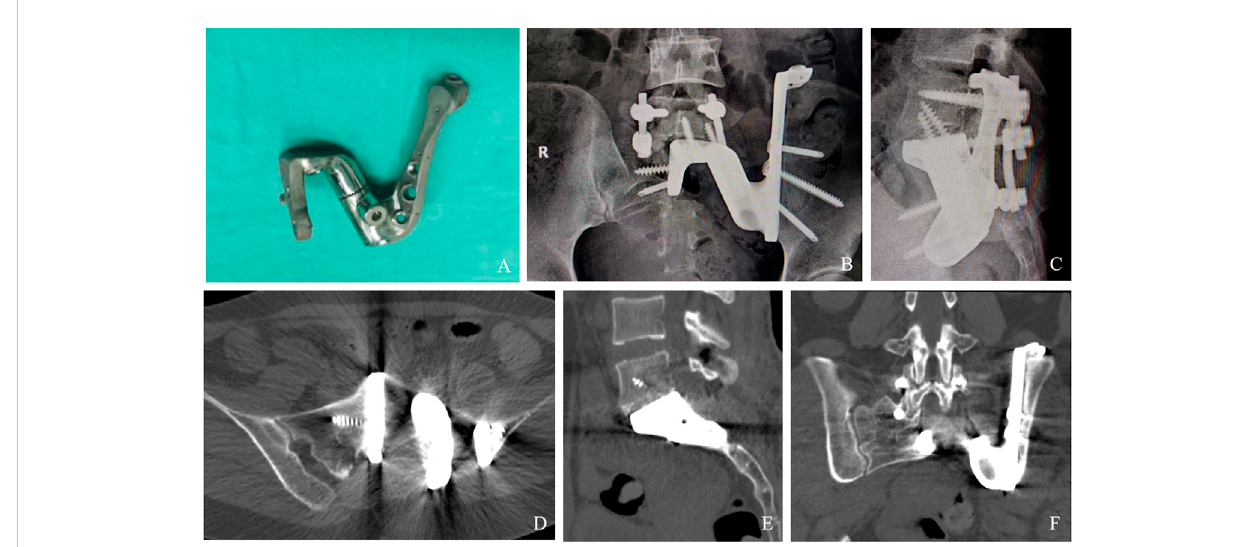
FIGURE 4 Results of prosthesis implantation. Physical object of the implant (A) . X-ray examination 3 years after operation (B, C) . CT showing excellent osseointegration at the bone – implant junctions in axial (D) , sagittal (E) , and coronal (F) views.